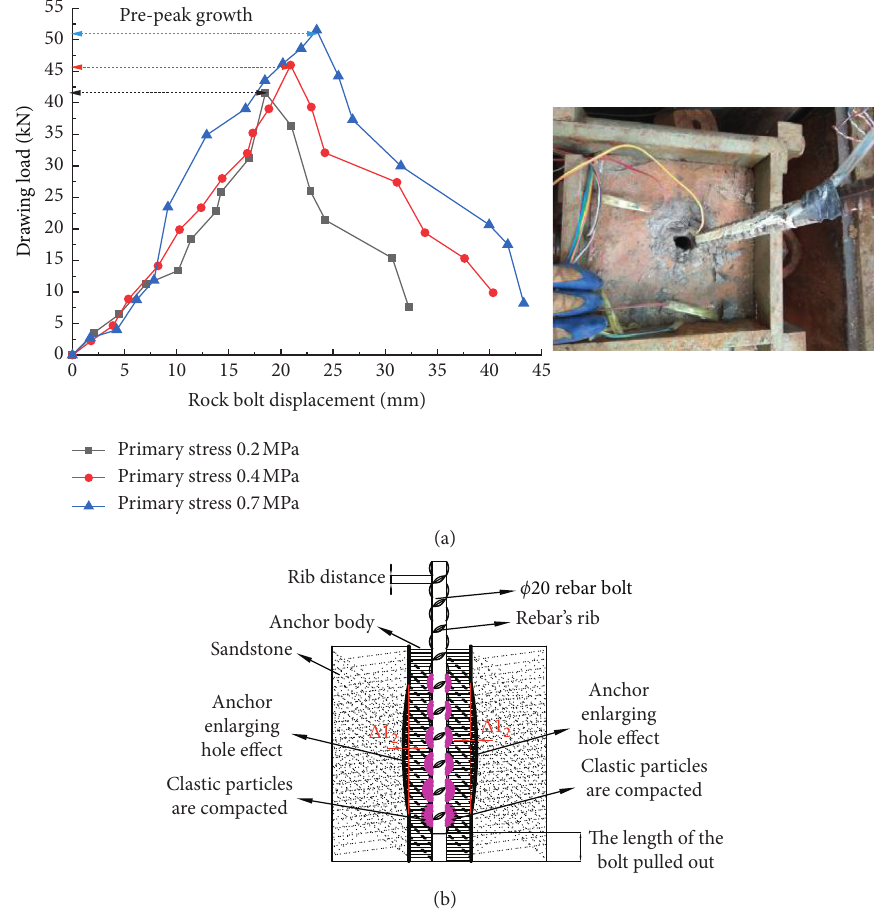
Figure 17: Load-displacement curve, failure mode, and mechanism diagram of anchor interface.(a) Drawing curve and failure pattern diagram. (b) Failure mechanism diagram.